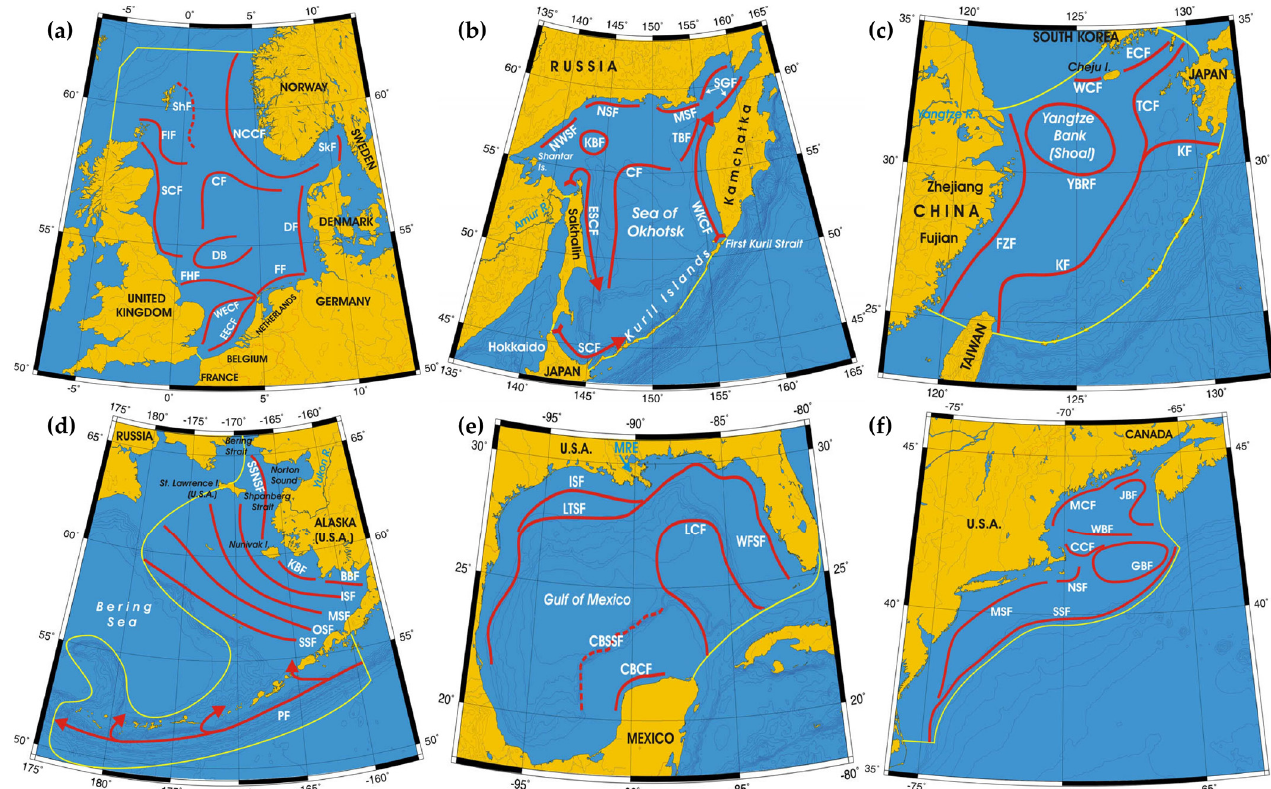
Figure 2. Distribution of main ocean fronts in some global sea areas [3]: ( a ) the North Sea; ( b ) the Sea of Okhotsk; ( c ) the East China Sea; ( d ) the East Bering Sea; ( e ) the Gulf of Mexico; and ( f ) the Northeast US Continental Shelf. The red lines represent the main axes of ocean fronts. The yellow lines represent the boundary of the Large Marine Ecosystems (LMF).